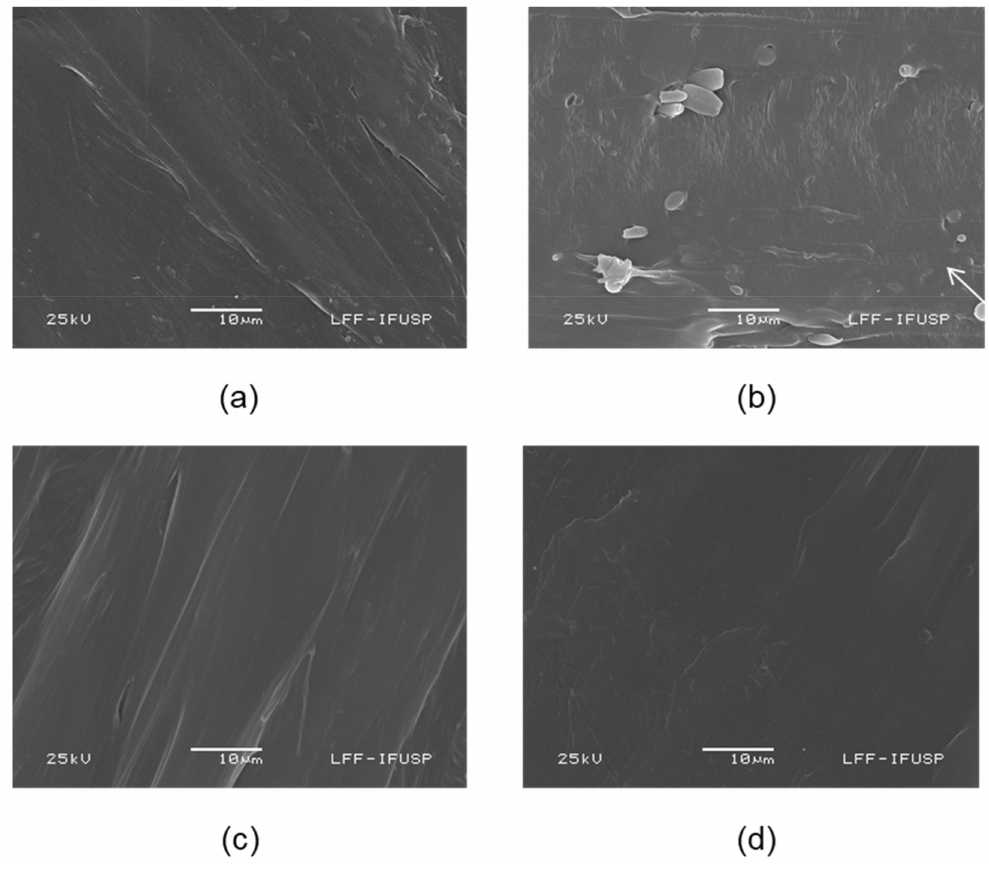
Figure 5. Cross-section scanning electron micrographs of pristine PP and PP composites contaning 5 wt% of lignin: ( a ) pristine PP; ( b ) PP/KL composite; ( c ) PP/A-Oxy-KL; ( d )